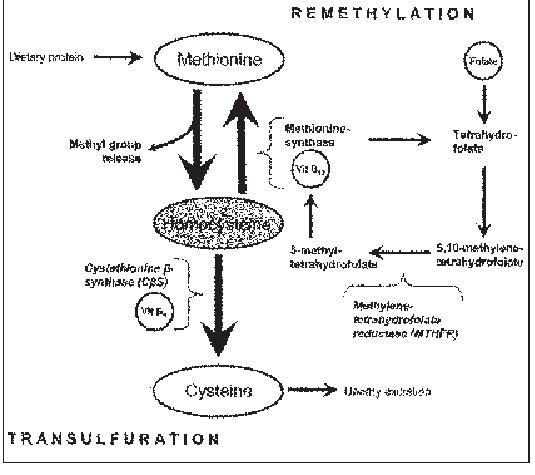
Major metabolic pathways of